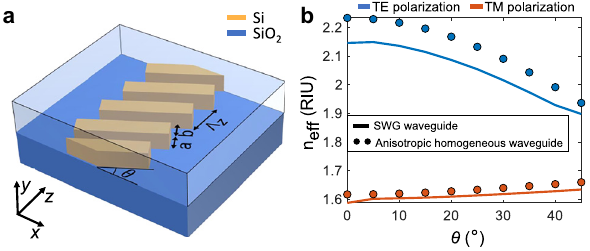
Figure 7: (a) Schematic representation of a tilted SWG waveguide. The period of the structure, Λ z = Λ /cos( θ ), is much shorter than the wavelength, λ , of the light propagating along the z -axis. (b) Effective index of the fundamental TE and TM modes of the tilted subwavelength waveguide and the anisotropic homogeneous